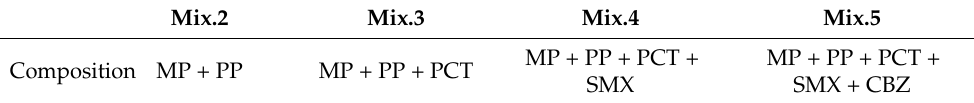
Table 2. Composition of PPCPs mixtures used in the ozone reactions (each compound dosed at 1 mg L − 1